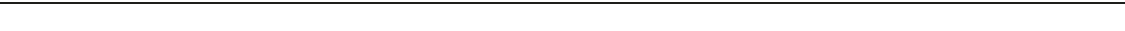
Fig. 2 Kinases driving the pro fi les of the relapsed cases. a Example of a chart of normalized enrichment scores (NESs) (left) obtained for CLK1 from the relative abundance of its phosphorylated substrates in either the relapsed or the non-relapsed cases (right) — or kinase set enrichment analysis (KSEAS). Each substrate (phosphopeptide) is represented in the KSEA as a vertical black line. The proteins to which they map are represented in the right column by their encoding genes, adjacent to the site at which phosphorylation was detected. In this column, a larger or shorter horizontal bar depicts, for each substrate, the Log 2 -fold regulation in the relapsed (blue) versus non-relapsed (red) cases. b Two phosphatase (DUSP6 and PP2C- δ ) and 9 kinase domains were enriched in the relapsed cases. The fi nding of an enriched phosphatase domain can be accounted for by the presence of a high concentration of a substrate for that phosphatase in a speci fi c subgroup of patient tumors or cell lines. The in silico tool cannot predict whether a phosphatase is functional based on the absence of phosphorylation of its putative substrates; however, it can predict which upstream kinases or phosphatases can bind (and phosphorylate or cleave) an identi fi ed substrate. P -values and false discovery rates (FDR) are depicted for each kinase or phosphatase. Although most KSEAS show a low FDR, a relaxed FDR boundary (up to 0.25) was allowed to ensure as little information loss as possible in the mass